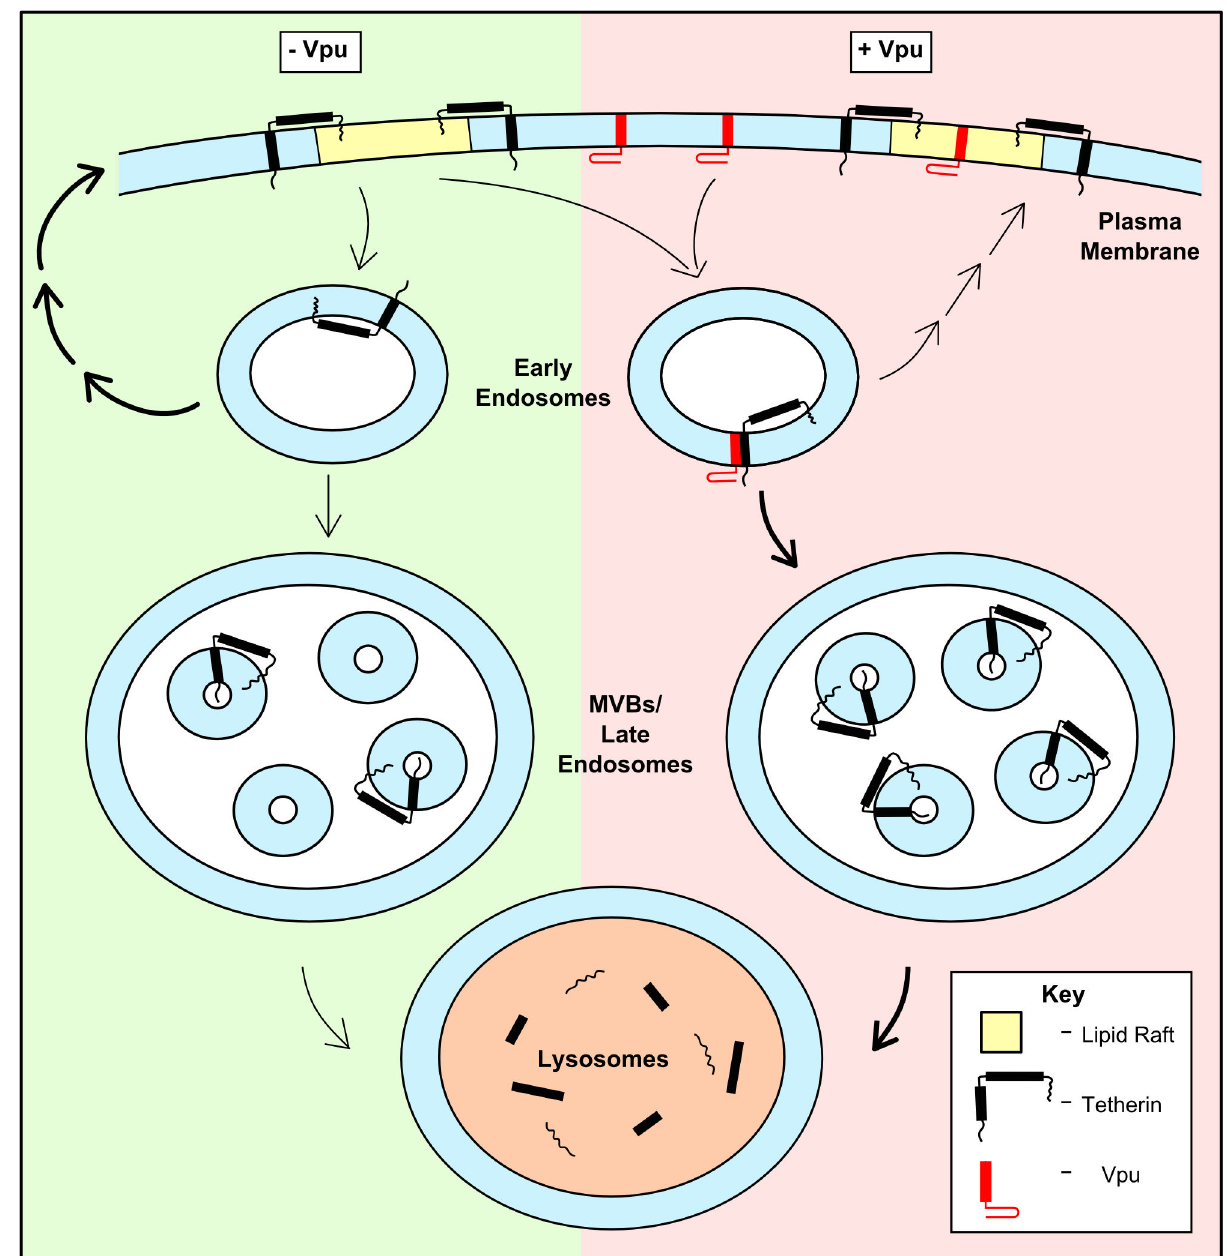
Figure 7. Cartoon representation of the effect of Vpu on tetherin trafficking following internalisation from the cell surface. The left hand side of the cartoon (green) shows what happens to cell surface tetherin in the absence of Vpu. It is internalised and delivered to early endosomes. During this process it exits lipid rafts. The majority of tetherin molecules then end up being recycled to the cell surface, probably via one or more intermediate compartment (as indicated by the thick arrows) whilst some tetherin ends up in multivesicular bodies (MVBs)/late endosomes and is ultimately destined for lysosomal degradation. Thus the fate of internalised tetherin is finely balanced between recycling to the cell surface and lysosomal degradation. The right hand side of the cartoon (pink) shows what happens to cell surface tetherin in the presence of Vpu. Both are internalised and delivered to early endosomes (with tetherin once again exiting lipid rafts along the way) where they associate with one another. This association leads to a shift in the balance between recycling and lysosomal degradation for tetherin, with the majority of tetherin now destined for delivery to MVBs/late endosomes and then to lysosomes (as indicated by the thick black arrows). NB this cartoon illustrates only the effect of Vpu on the fate of internalised tetherin.